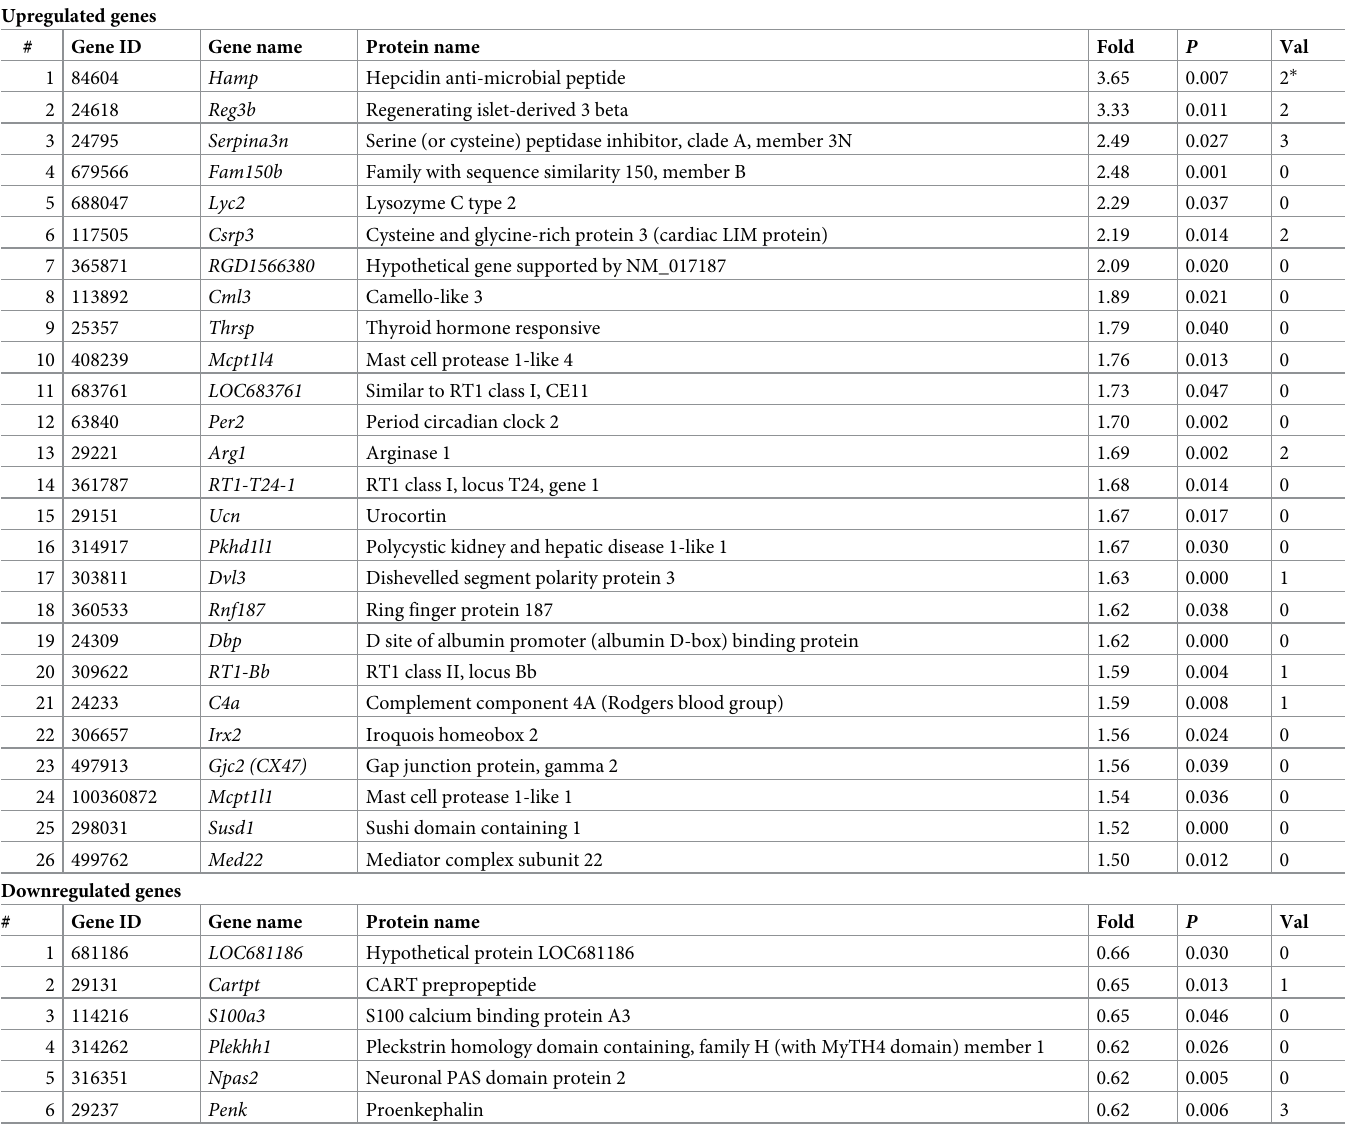
Table 1. List of significant upregulated ( > 1.5 fold) and downregulated ( < 0.67 fold) genes. Upregulated